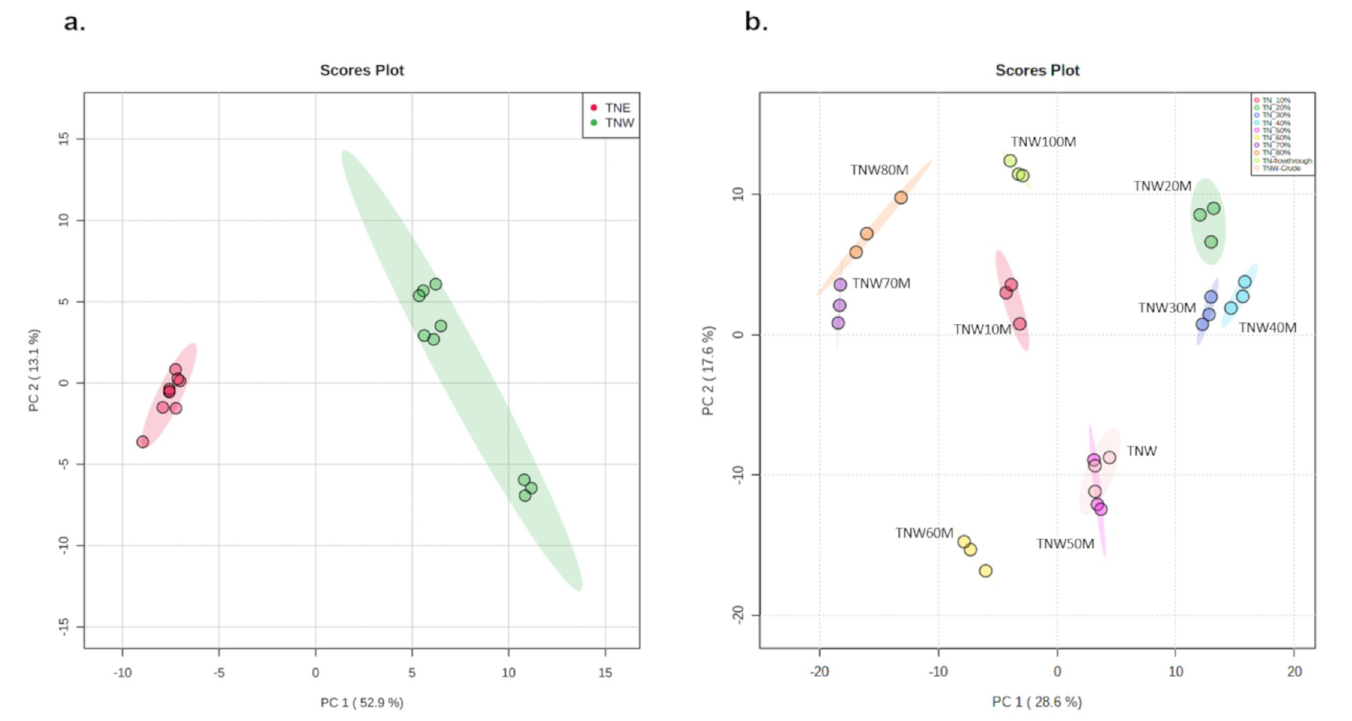
Fig 5. Multivariate analysis of phytochemicals identified in TNW, TN50E extracts and methanolic fractions. ( a ) Score plot of PCA analysis comparing TNW (green) and TN50E (red) extracts. ( b ) Score plot of PCA analysis comparing TNW methanolic fractions. MetaboAnalyst software was used to perform the analysis.